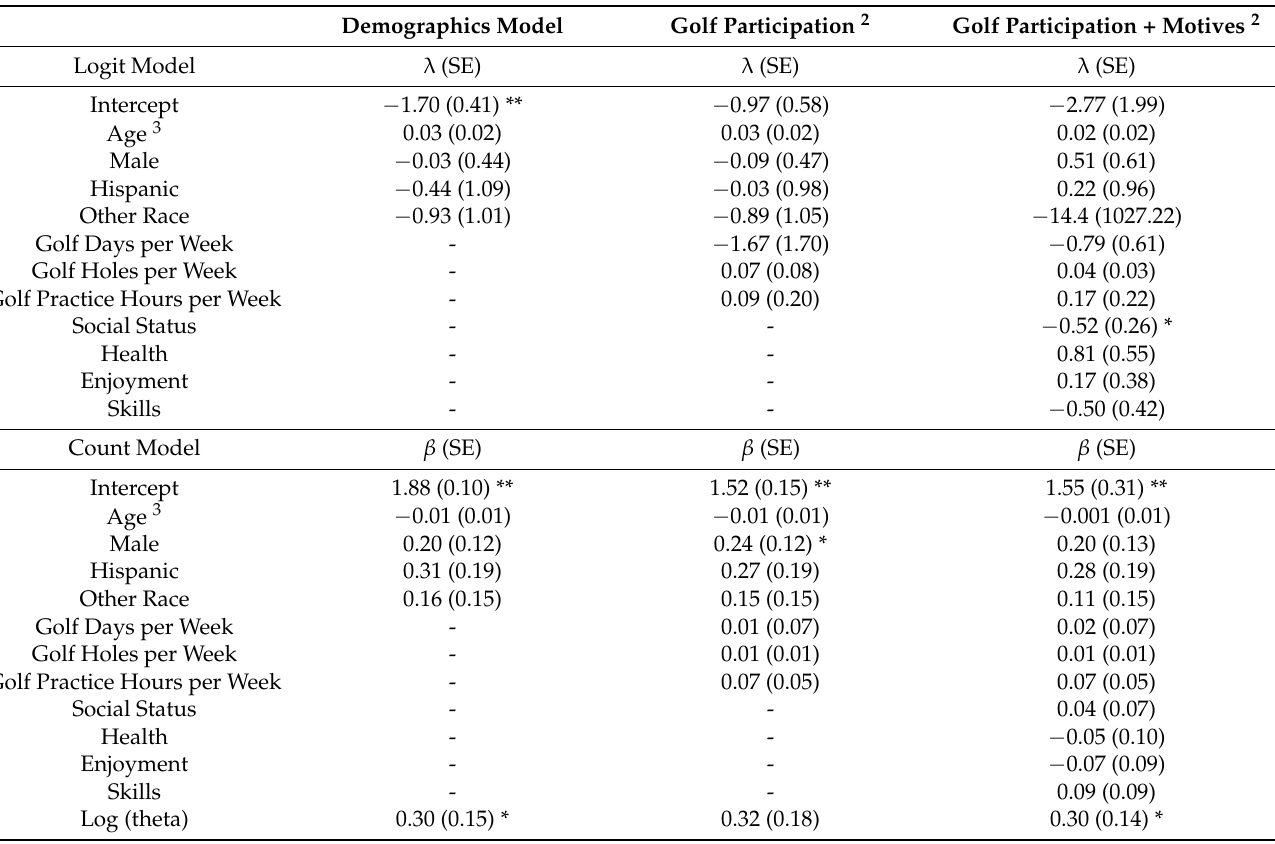
Table 4. Zero-inflated negative binomial models with demographics, golf participation, and golf participation plus motives predicting alcohol servings per week 1